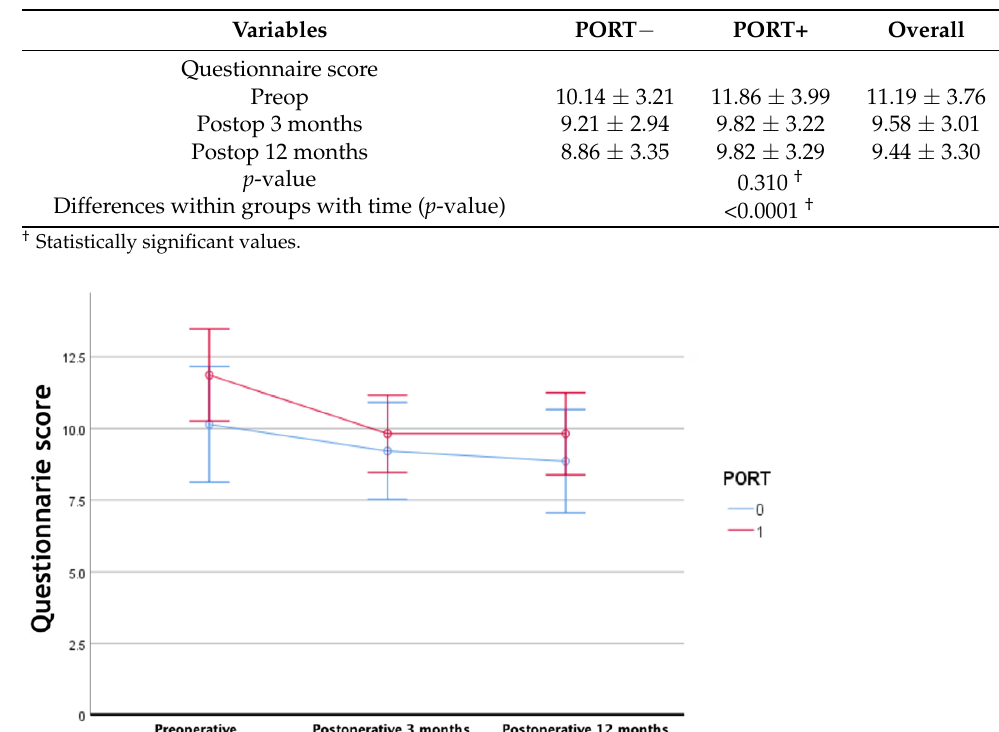
Table 6. Univariate and multivariate analyses for predictors of dietary function.